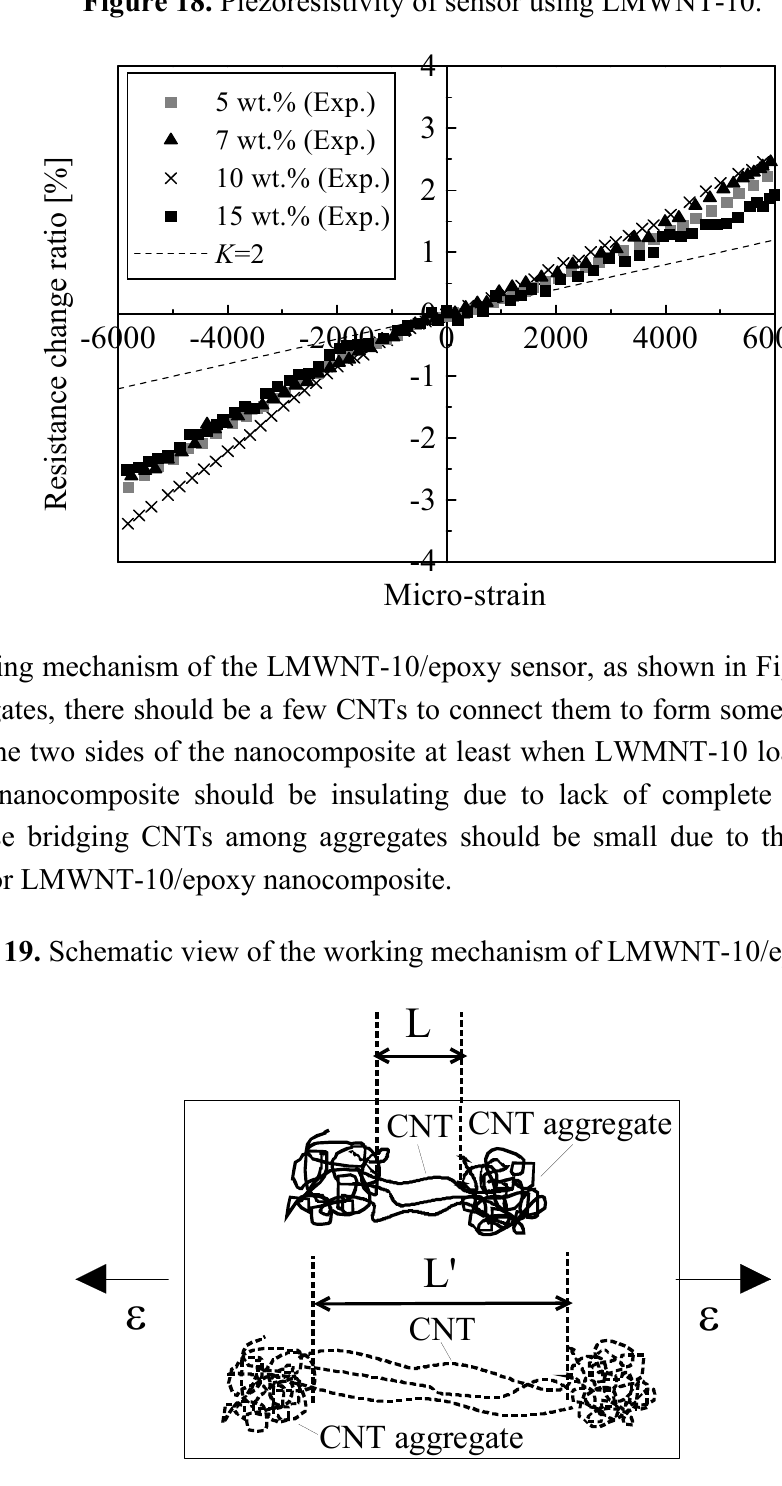
Figure 18. Piezoresistivity of sensor using LMWNT-10.